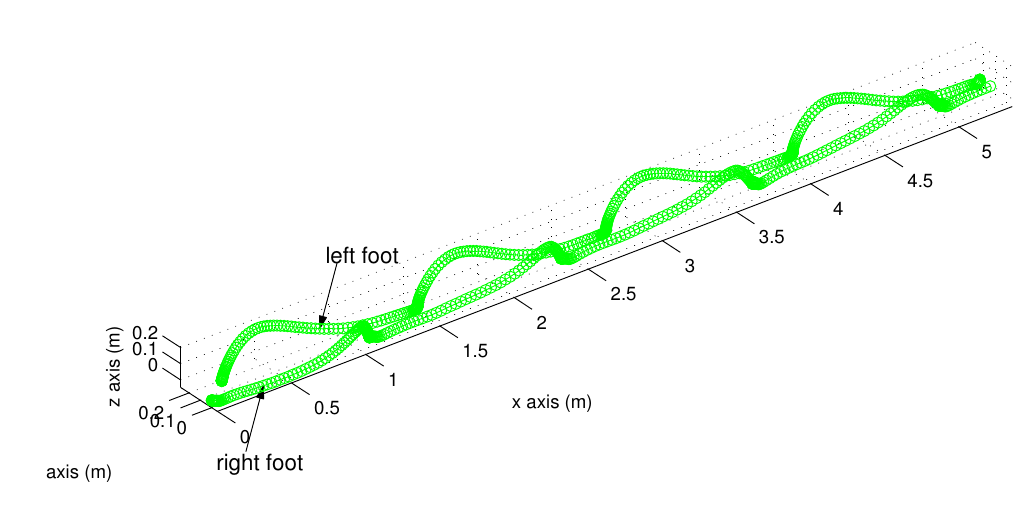
Figure 8. Estimated trajectories in the three dimensional space.